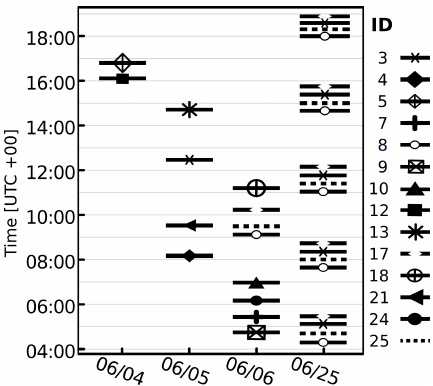
Figure 8. Summary of UAS flights. The areas correspond to the CRNS sensor ID (see Fig. 1). Every flight had a flight duration of approximately